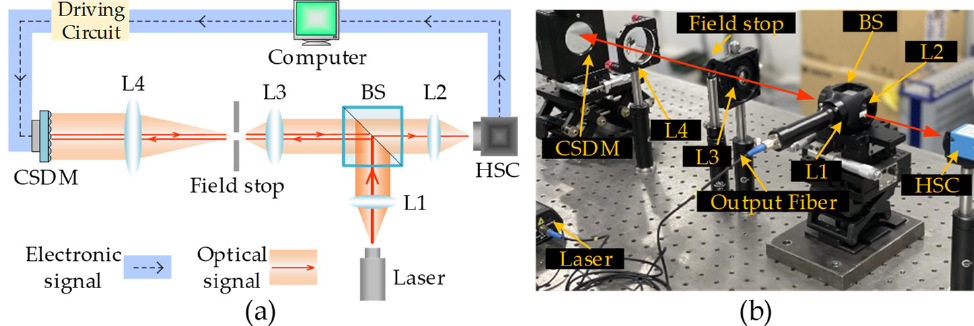
Figure 10. Setup and photograph of the SLAO experiment platform. ( a ) Optical layout of the platform. The optical signal is colored in orange and the electronic signal is colored in blue for easy distinction. ( b ) Photograph of the platform. The focal lengths of L1–L4 lenses are 10 mm, 10 mm, 5 mm and 15 mm, respectively.